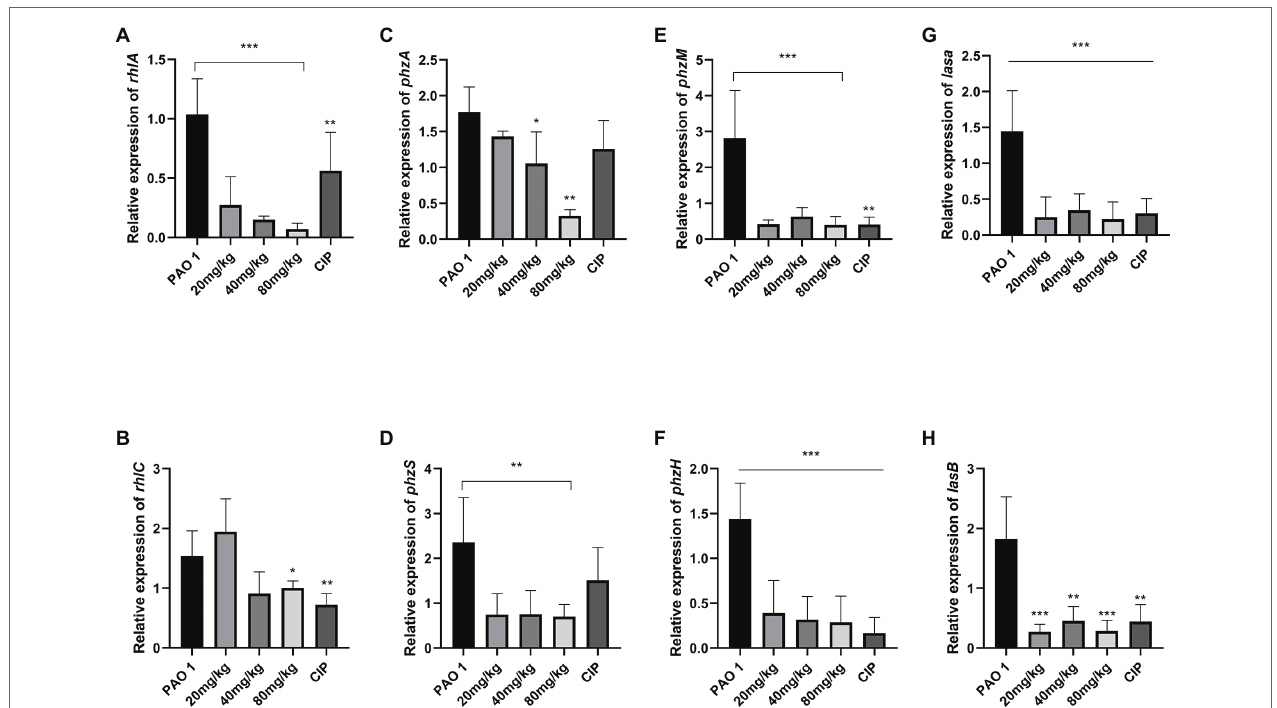
FIGURE 3 | The inhibition of EGCG on the expression of QS-regulated virulence factors in the lung challenged by P. aeruginosa . (A) rhlA , (B) rhlC (C) phzA , (D) phzS , (E) phzM (F) phzH , (G) lasA , (H) lasB . Data are presented as mean ± SD and analyzed with one-way ANOVA. * p < 0.05, ** p < 0.01, *** p < 0.005 vs. PAO 1